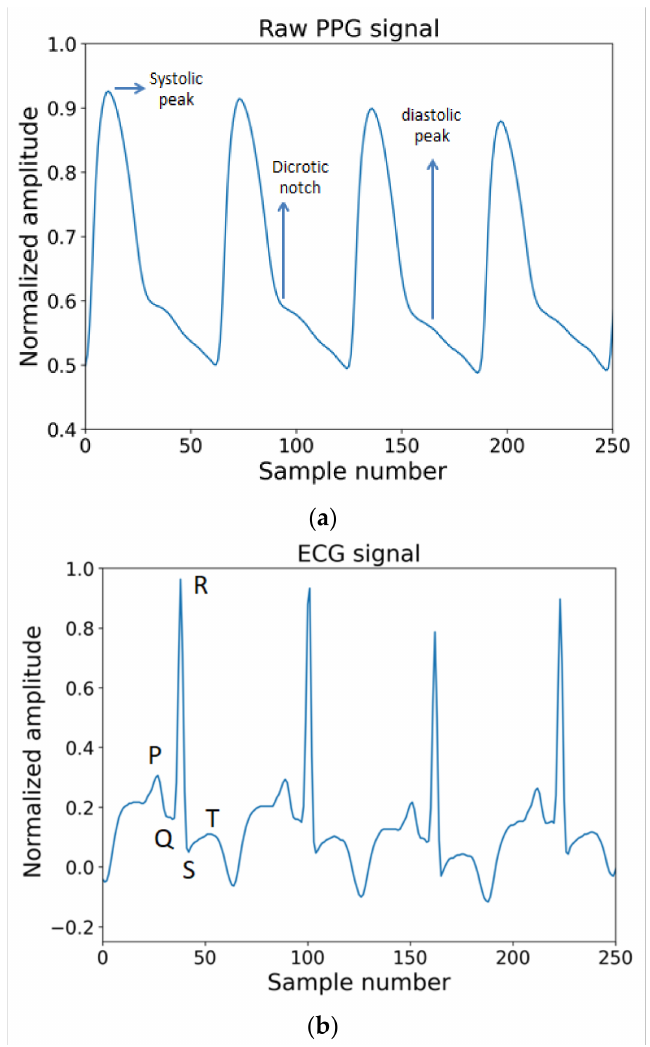
Figure 2. ( a ) A single PPG signal. ( b ) Electrical activity pattern from ECG